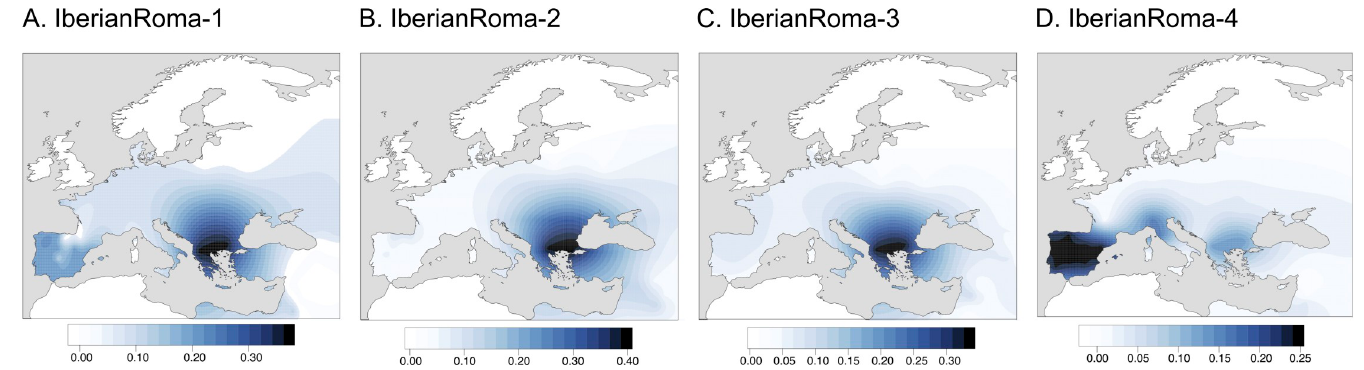
Fig 3. West Eurasian ancestry of the Iberian Roma (Dataset2). Kriging model of the spatial distribution of the major source donor proportion inferred with GLOBETROTTER, reflecting the West Eurasian ancestry proportions in each Roma group